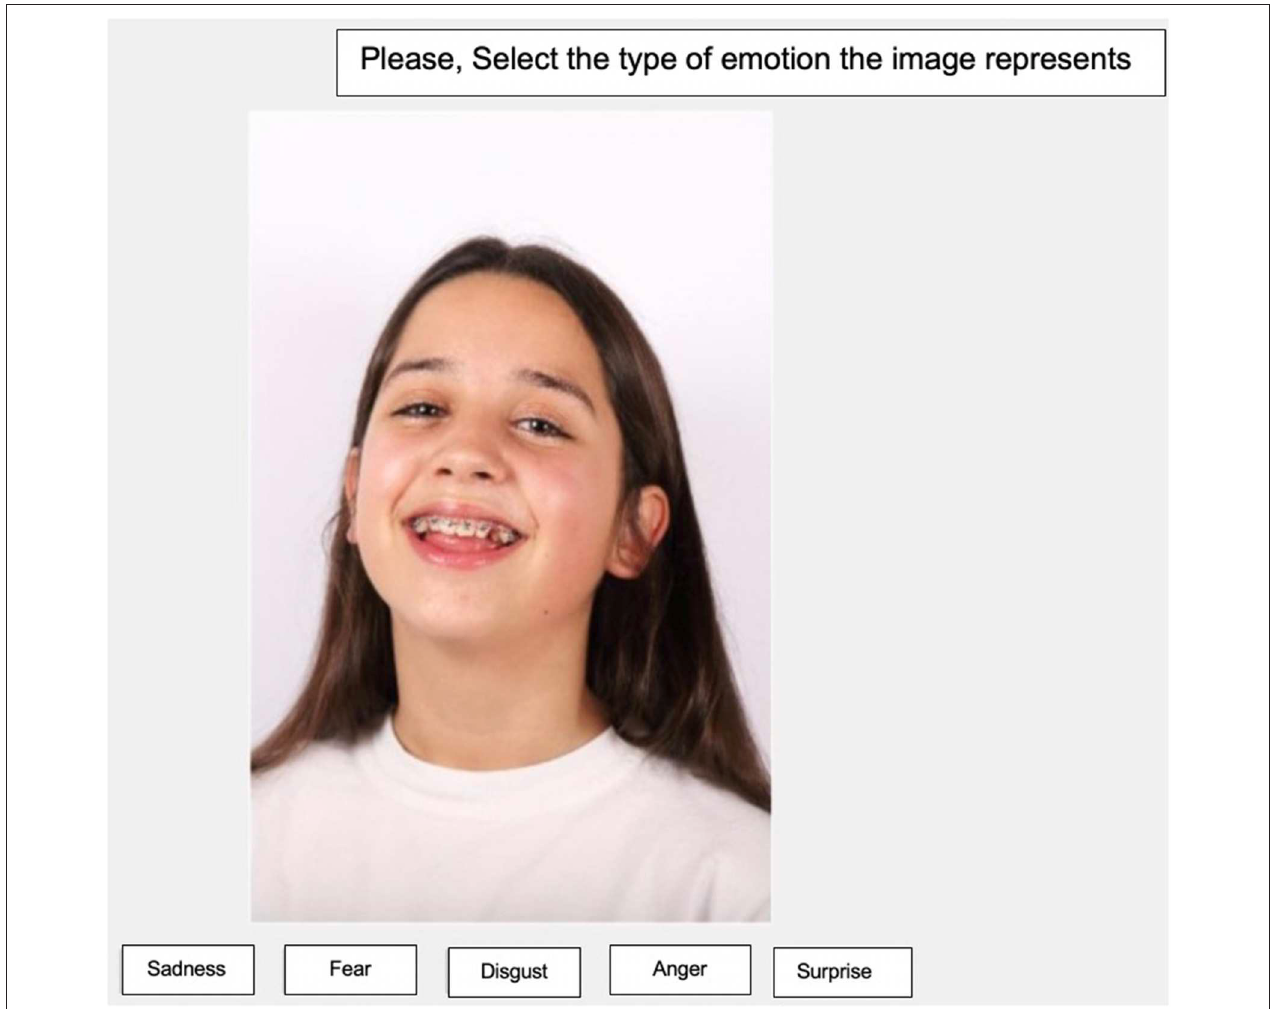
FIGURE 4 | Reactive female model facial expressions of happiness high intensity.